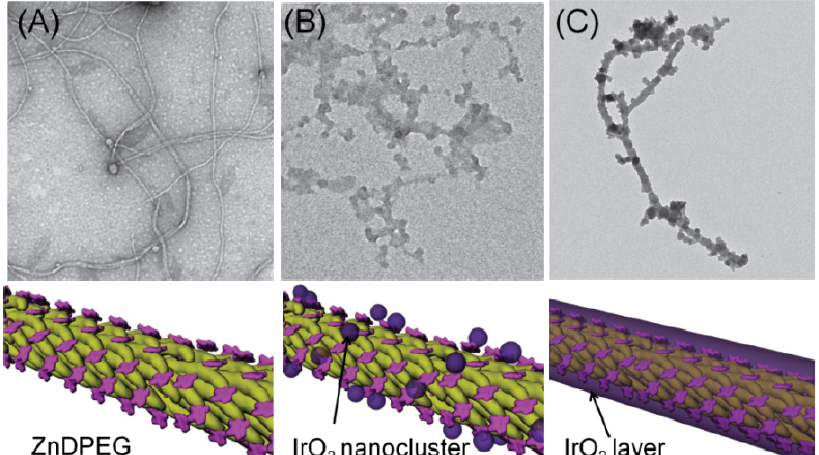
Figure 7. Construction of phage particles decorated with iridiumoxide nanoparticles co- assembled with ZnDPEG. (A) ZnDPEG grafted phage (B) iridium oxide nanoparticle nucleation via iridumoxide binding peptides on phage coat (C) final form of phage nanowire coated iridiumoxide. Reprinted by permission from Macmillan Publishers Ltd: Nature Nanotechnology [93], copyright